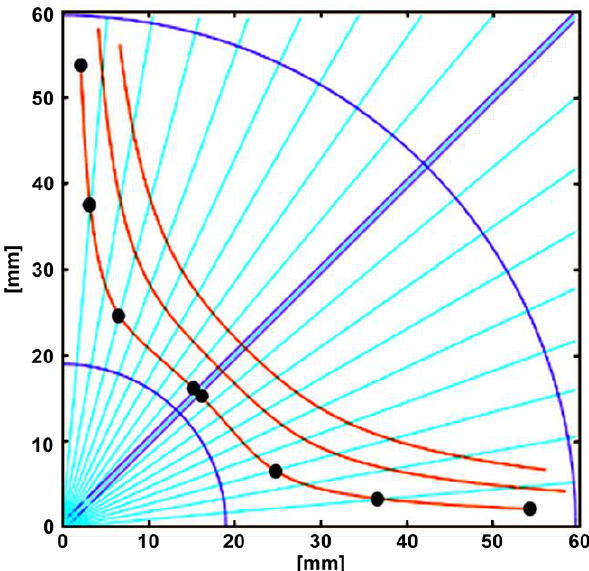
Figure 4. The 3 lines of the first barrier are in red, and the points were chosen to be parameterized for the lower line.